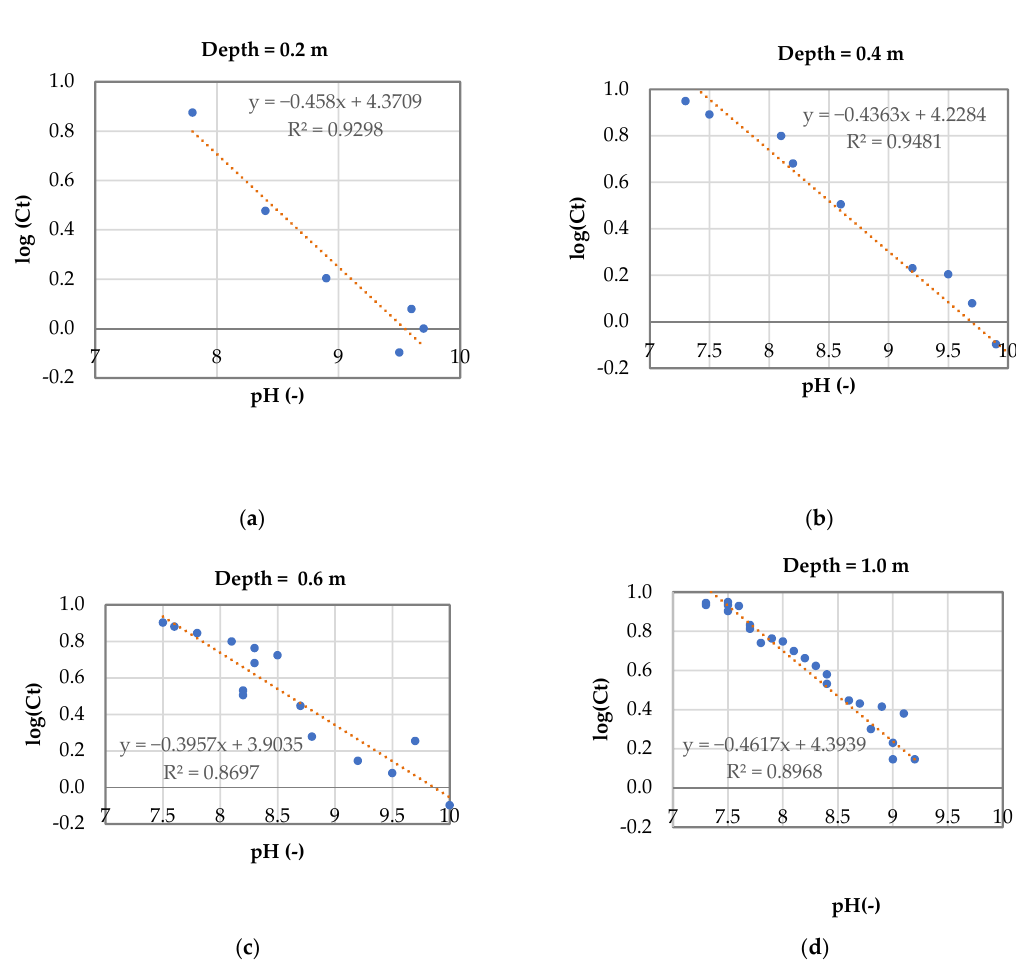
Figure 6. ( a ) Experimental profiles of the logarithm of the total phosphorus concentration as a function of pH for a pond depth of 0.2 m; ( b ): Experimental profiles of the logarithm of the total phosphorus concentration as a function of pH for a pond depth of 0.4 m, ( c ): Experimental profiles of the logarithm of the total phosphorus concentration as a function of pH for a pond depth of 0.6 m, ( d ): Experimental profiles of the logarithm of the total phosphorus concentration as a function of pH for a pond depth of 1.0 m.